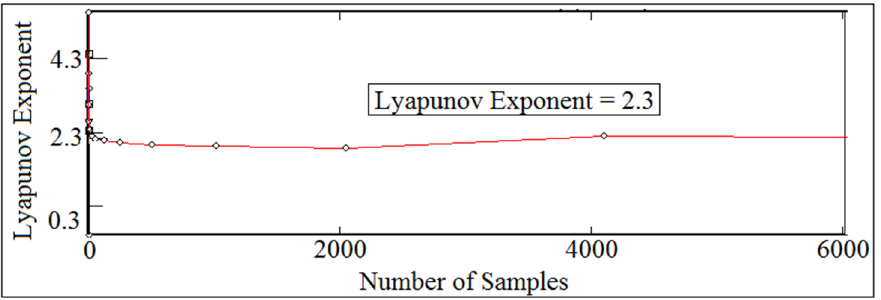
Figure 18. Local Lyapunov exponent against number of samples for (I.D. = 16 mm) and (N = 400 rpm).